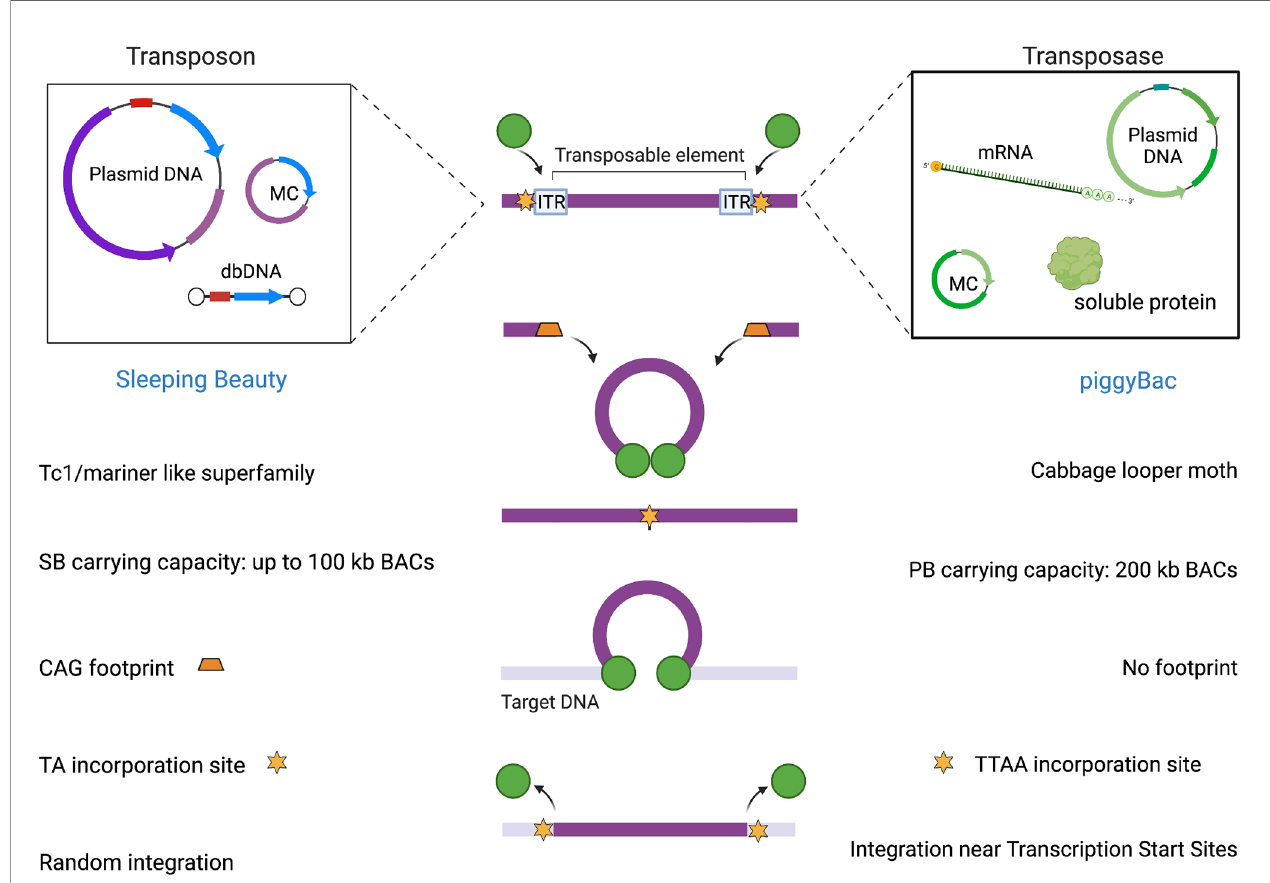
FIGURE 2 | SB and PB mediated